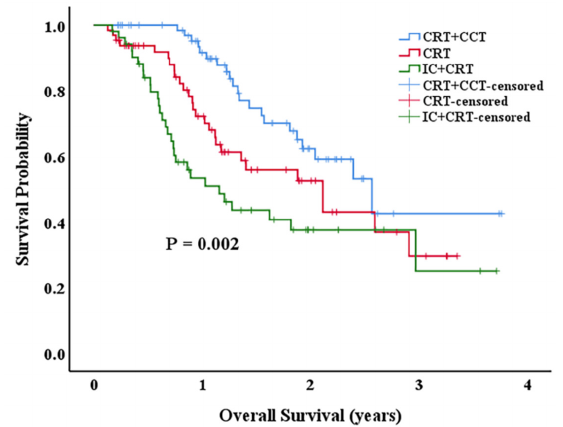
Figure 1. OS of patients for IC + CRT, CRT, and CRT + CCT group.